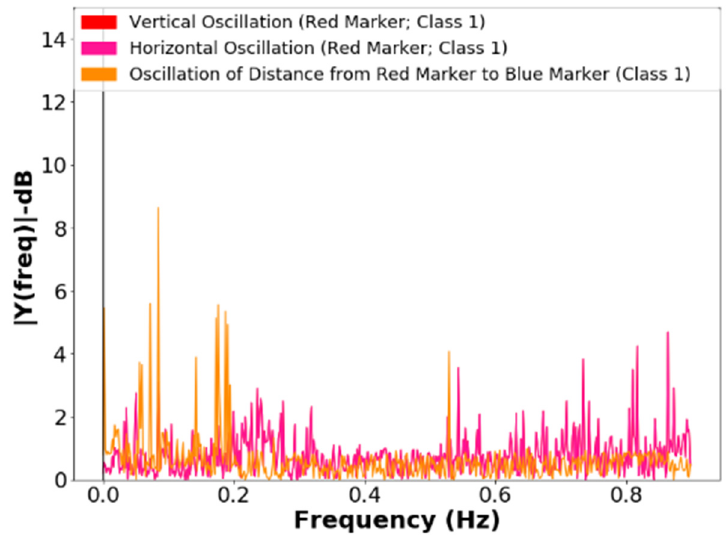
Figure 15. Frequency spectrum of the vertical and horizontal oscillations of the red marker, in the lifting operation, class 1.